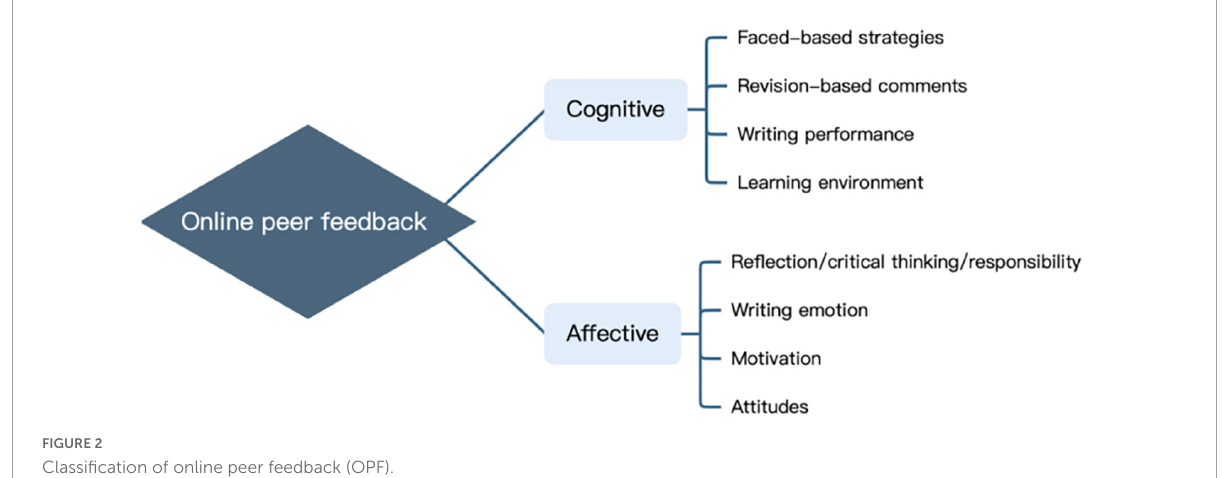
FIGURE2 Classification of online peer feedback (OPF).